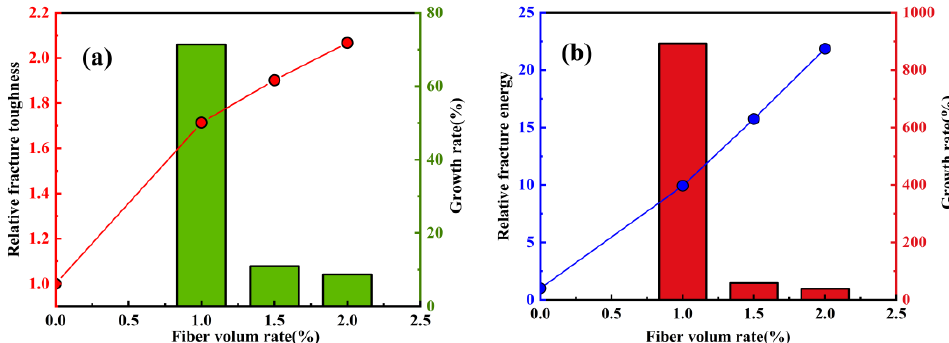
Figure 27. The effect of fiber volume rate on fracture properties of ultra-high-performance geopol- ymer concrete: ( a ) Relative fracture toughness; ( b ) relative fracture energy. concrete: ( a ) Relative fracture toughness; ( b ) relative fracture